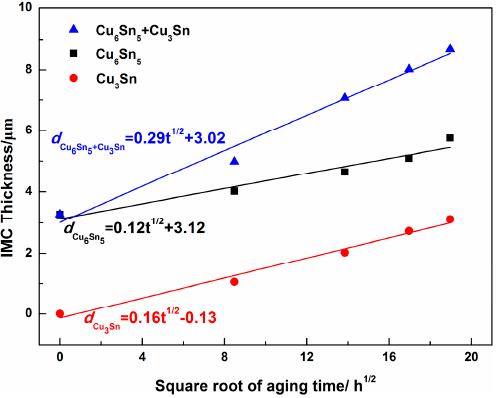
Figure 9. Linear fit of interfacial IMC thickness versus square root of aging time.